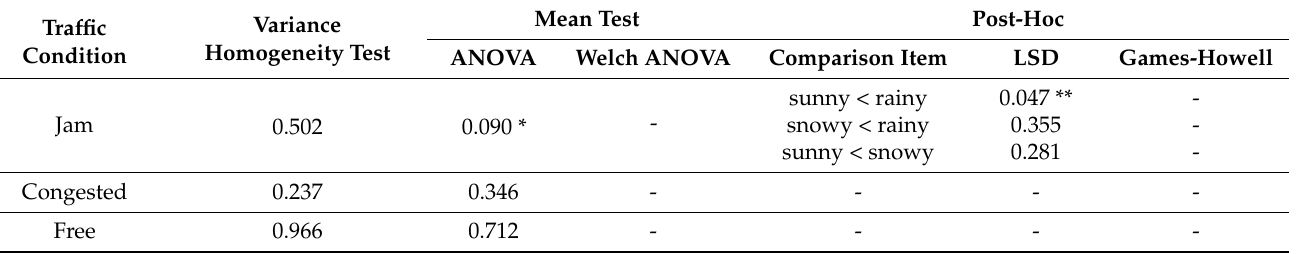
Table 8. The significance test of the influence of weather conditions on the minimum time headway.